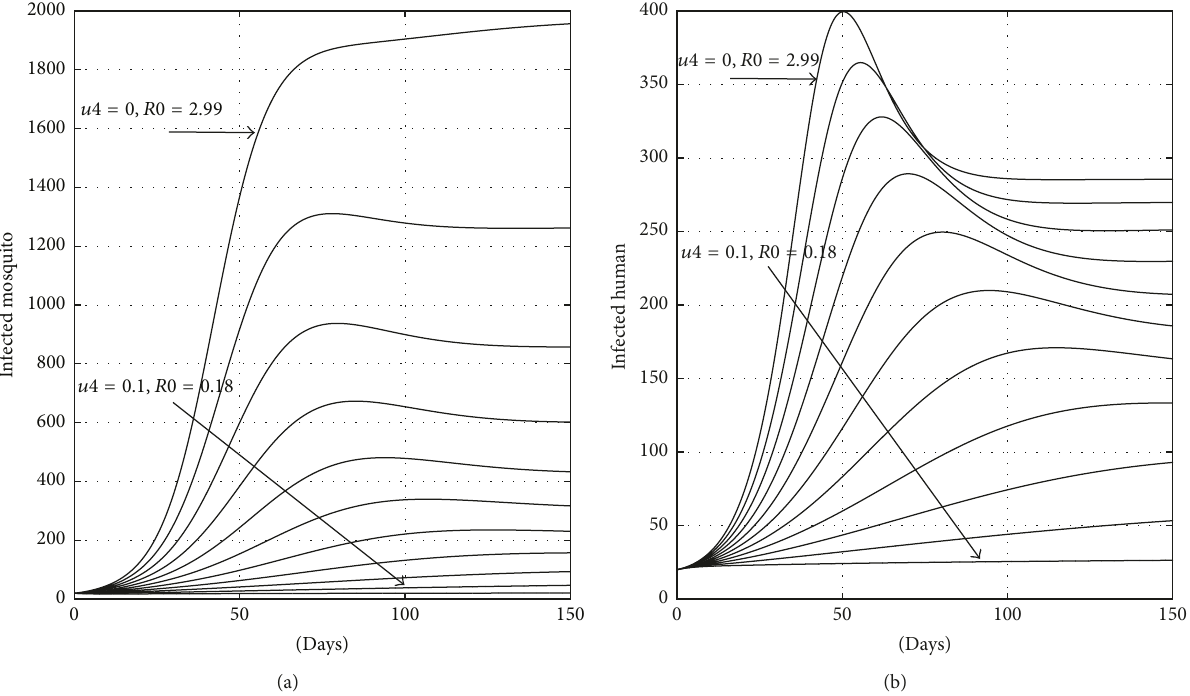
Figure 7: Sensitivity of 𝑢 4 with respect to the number of infected mosquitoes (a) and infected humans (b).